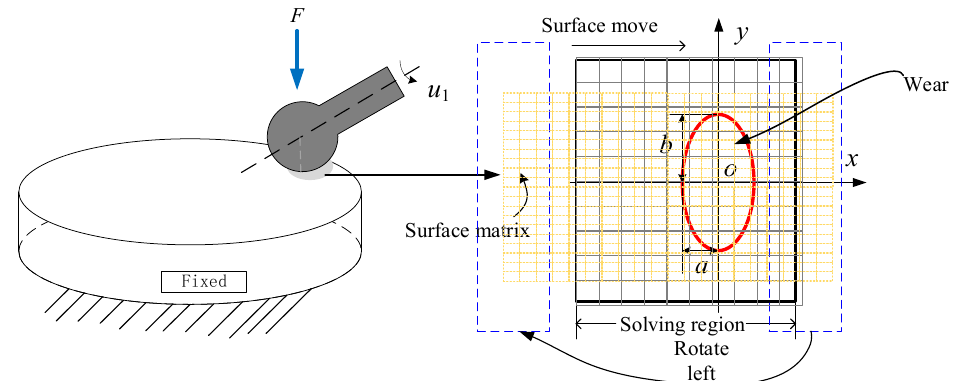
Fig. 2 Three-layer independent grid of the contact